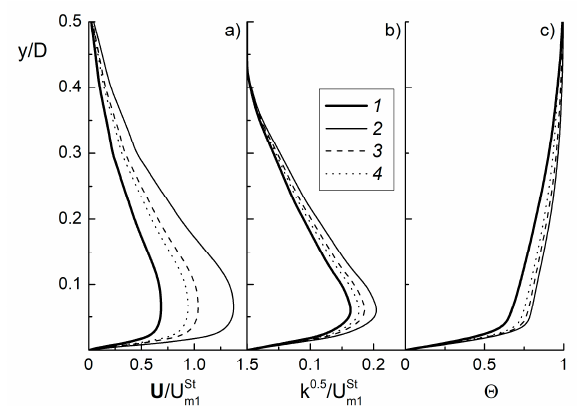
Figure 4. Velocity magnitude U ( a ), turbulent kinetic energy k ( b ) and temperature Θ ( c ) transverse distributions in the pulsed impinging jet normal to the surface at t = 0.5 t c . Re = 23000, H / D = 2, T W = 373 K, T 1 = 293 K, f = 60 Hz, St = 0.069, r / D = 1. 1 —steady-state impinging jet ( f = 0 Hz), 2 —rectangular, 3 —sinusoidal, 4 —triangular.